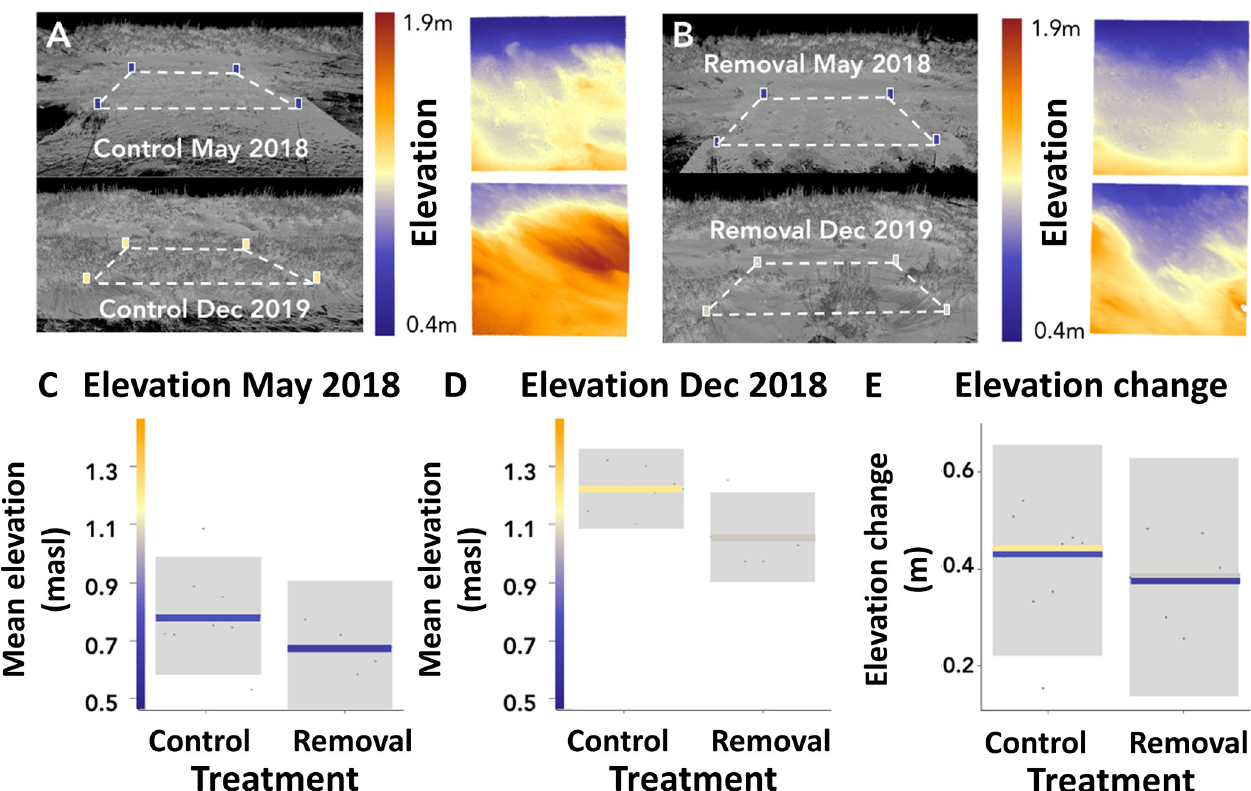
Fig 4. Effects of wrack on geomorphological variables. Laser scan images of control (A) and removal (B) plots from initial and final geomorphological data collection time points and respective heat maps showing changes in elevation between the two time points. Blue edge to heat map represents seaward side of dune. C- E: All plots show the partial residuals from linear models accounting for experimental block as a function of treatment type. The variables shown are: mean elevation above sea level at initial data collection point (C) and final data collection point (D) , and difference of elevation between first and final time point (elevational change).I (E) . Grey areas are the 95% confidence intervals.